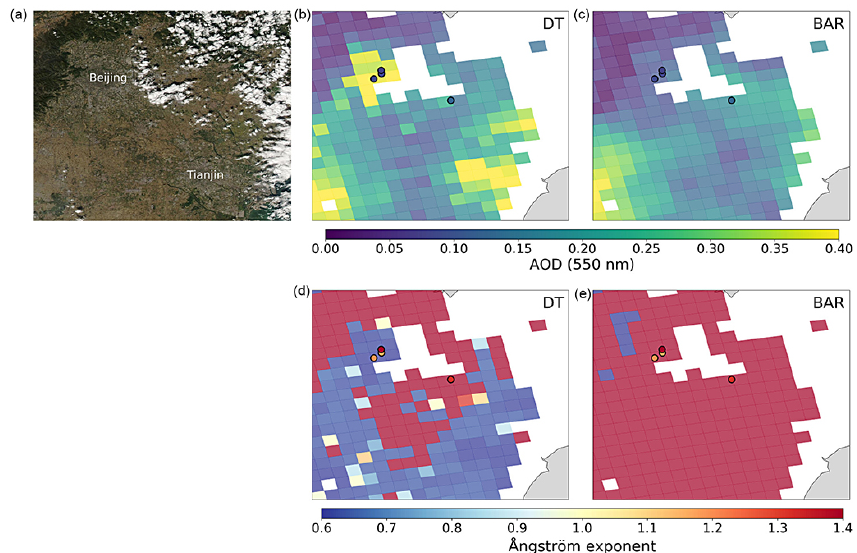
Figure 2. (a, b, c) True color image of MODIS Aqua overpass over Beijing area, China, on 11 October 2015 (a) , AOD retrievals computed with DT (b, d) and BAR (c, e) algorithms. (d, e) The Ångström exponent retrievals computed with DT (b, d) , and BAR (c, e) algorithms. The circles correspond to AERONET AOD and Ångström exponent values at the satellite overpass time.